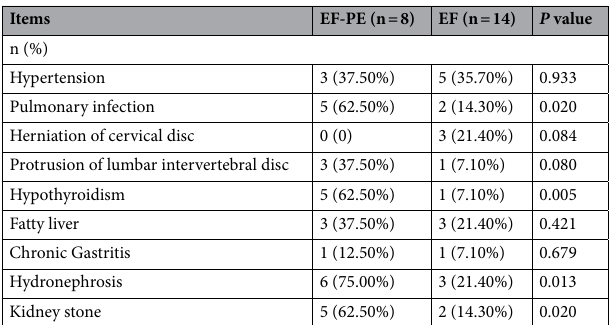
Figure 2. The levels of C-reactive protein, ESR, free triiodothyronine, free thyroxine, and thyroid stimulating hormone in EF-PE and EF groups. The levels of C-reactive protein ( A ), ESR ( B ), free triiodothyronine ( C ), free thyroxine ( D ), and thyroid stimulating hormone ( E ) were compared between EF-PE and EF groups. Comparisons between the two groups were performed by Student’s t test or the Mann–Whitney U test. P < 0.05 was considered statistically significant.